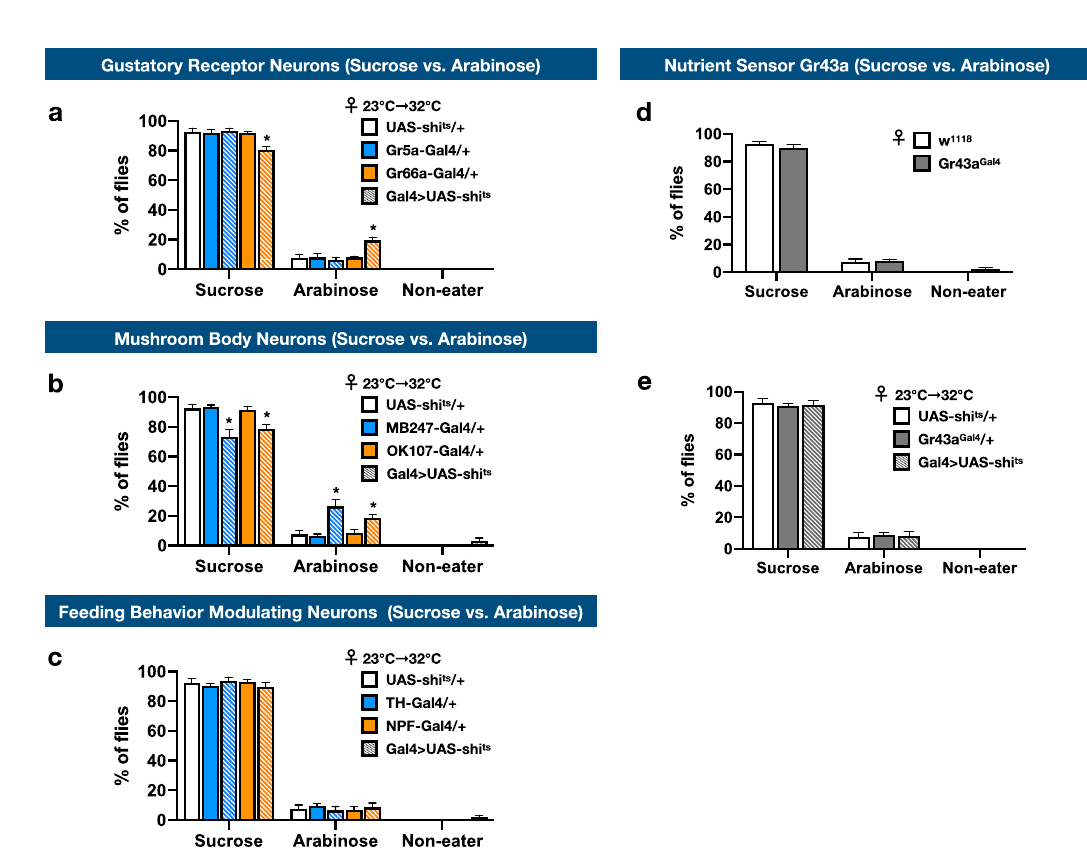
Fig. 5 Identi fi cation of neural circuits that modulate the making of complex VBFD. a – c , e VBFD assays (150 mM sucrose vs. 150 mM arabinose) were performed in female fl ies that have reduced activity in ( a ) gustatory receptor neurons (Gr5a-Gal4 and Gr66a-Gal4), ( b ) mushroom body neurons (MB247-Gal4 and OK107-Gal4), ( c) feeding behavior modulating neurons (TH-Gal4 and NPF-Gal4), and ( e) Gr43a- positive neurons (Gr43a Gal4 ). d VBFD assays were performed in female Gr43a mutants (Gr43a Gal4 ) at 25 °C. Results were expressed as means ± SEM and analyzed by two-way ANOVA. n = 100 for each condition. Note all the columns of UAS-shi ts / + were the same. In a – c , e , the fl ies were reared at 23 °C until 1 h before the VBFD assay (32 °C). The statistical signi fi cance was assessed by the comparison to UAS-shi ts / + controls. In ( d ), the fl ies were reared at 25 °C and the VBFD assays were performed at 25 °C. The statistical signi fi cance was assessed by the comparison to w 1118 . * p <